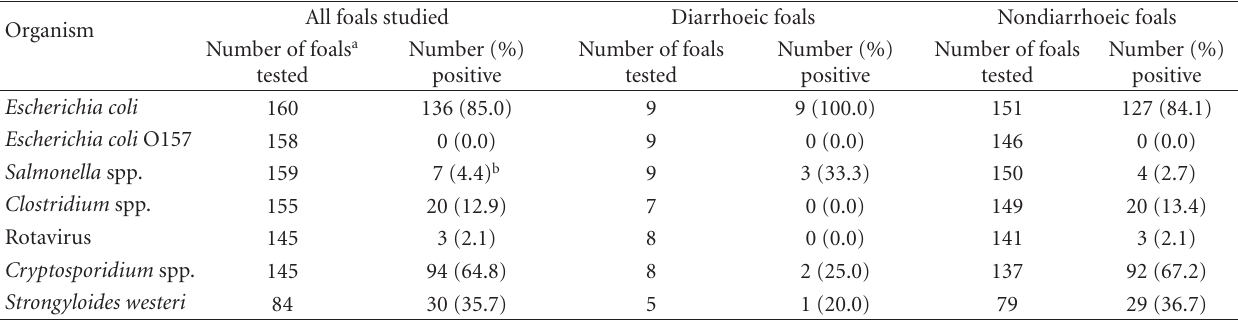
Table 1: Frequency of detection of enteropathogens in diarrhoeic and nondiarrhoeic foals. Organism